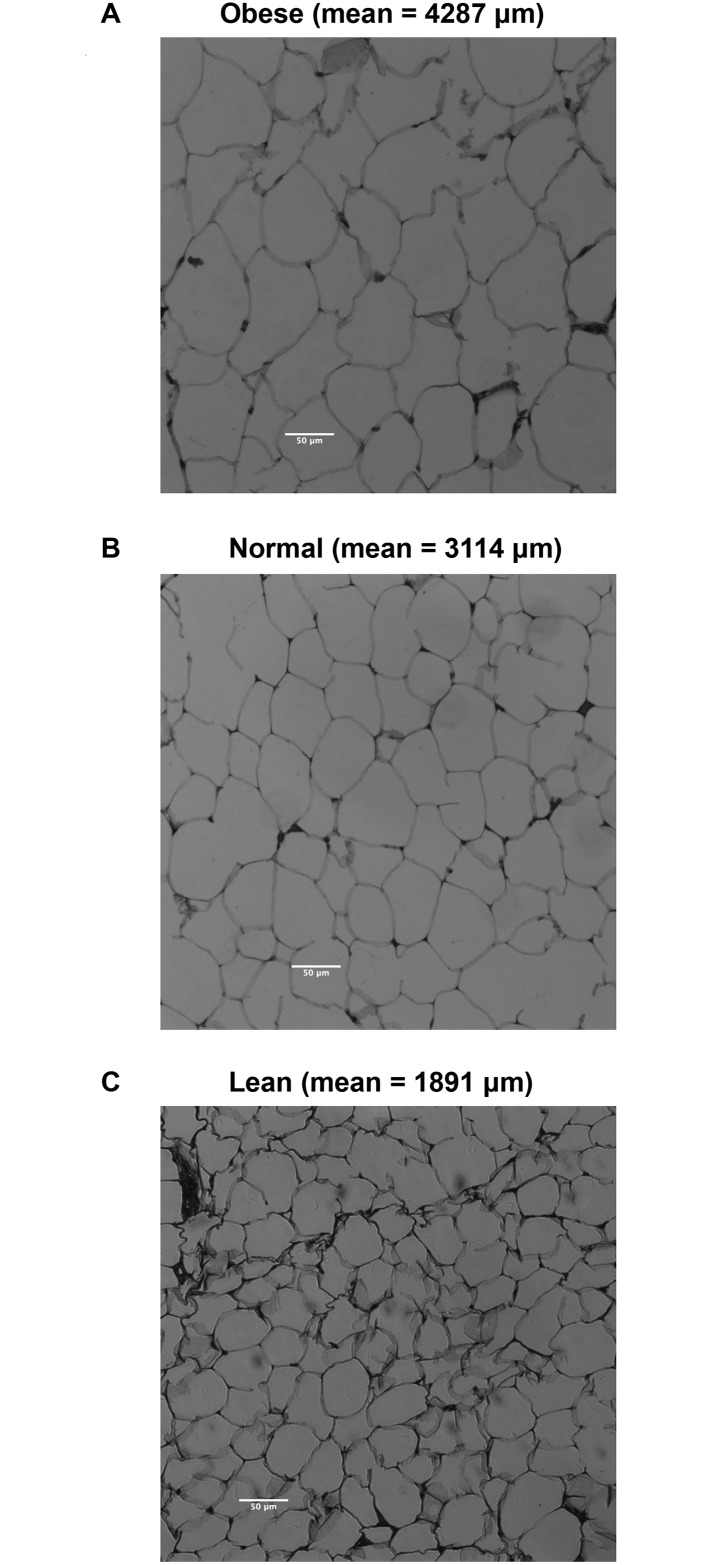
Adipocyte size area and morphology.(A) obese, (B) normal, and (C) lean adipocytes with the mean area listed.